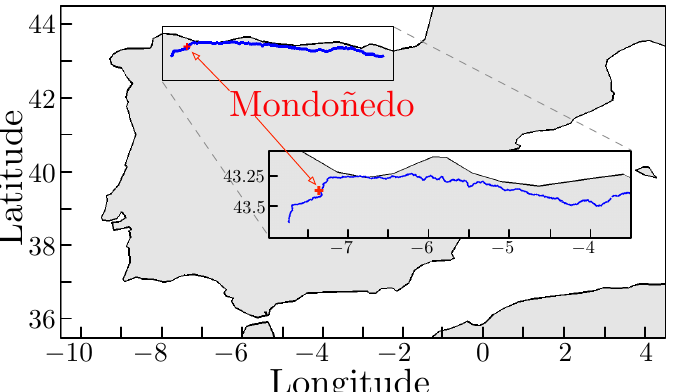
Figure 1. Location of the A-8 motor-road (in blue), and the situation of the measuring station in Mondoñedo (+ symbol in red), in Galicia, Spain. The zoomed image precisely determines the coordinates of Mondoñedo and the A8 motor-road.